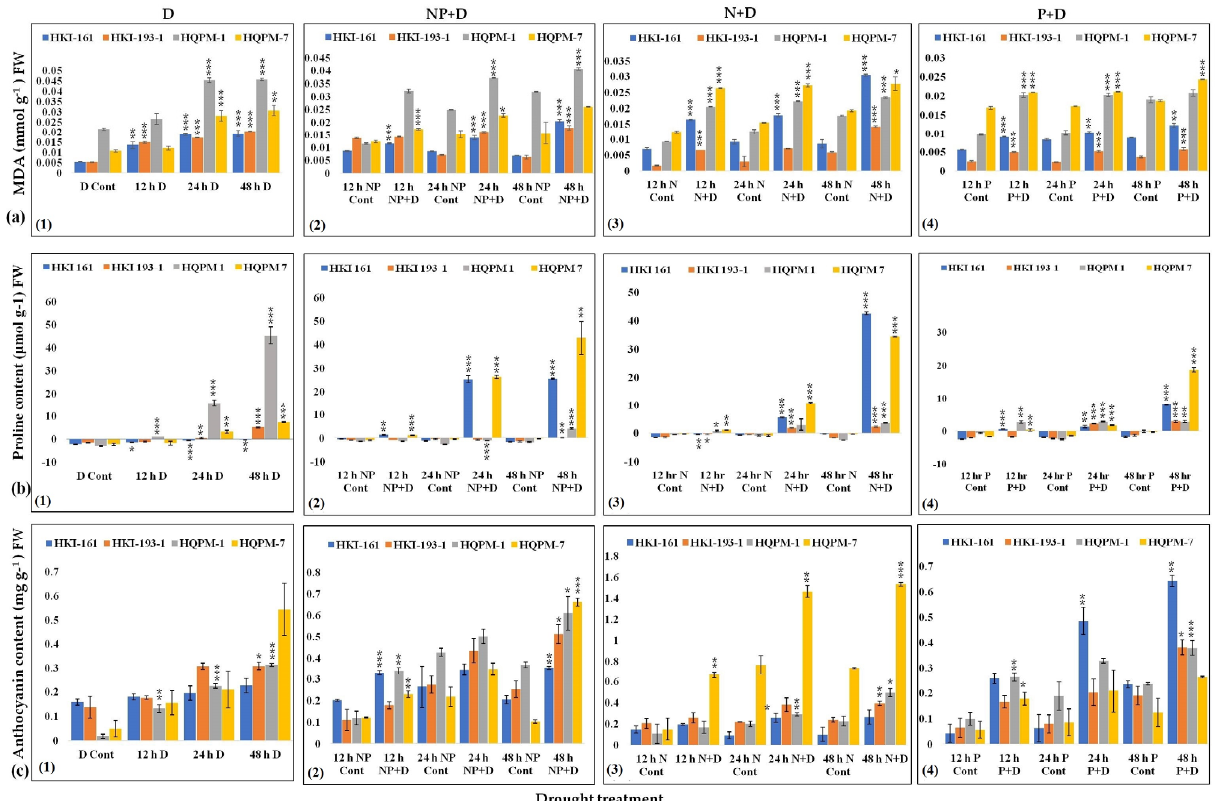
Figure 5. The effect of nutrient application on the ( a ) MDA, ( b ) free proline and ( c ) anthocyanin content in drought stressed (D) maize seedlings pretreated Nitrogen (N) and/or Phosphorous (P), respectively in the four genotypes. Subfigures show the respective response under drought stress ( 1 ) without nutrient pre-supplementation, ( 2 ) pre-treatment with NP, ( 3 ) pre-treatment with N and ( 4 ) pre-treatment with P. Bars represent the mean values and standard error obtained using three biological replicates. Asterisks indicate significant statistical differences: *** p < 0.001, ** p < 0.01, * p < 0.05.